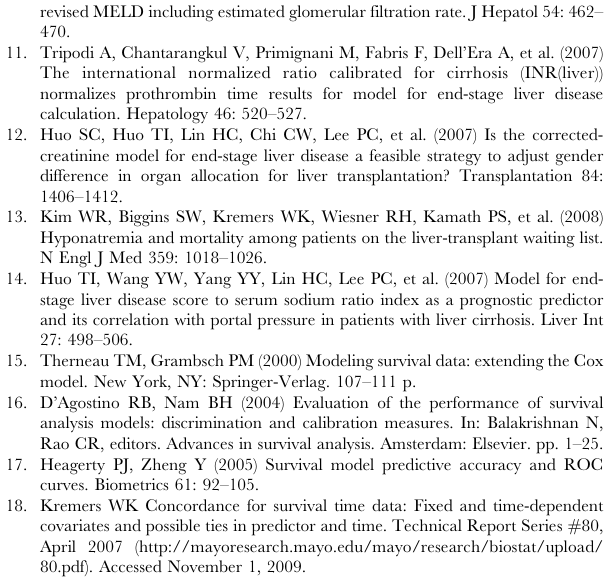
Figure S1 Serum albumin concentration and the risk of death within 3 months of waiting list registration after adjustment for the MELDNa score. Dotted lines repre- sent 95% confidence intervals. Table S1 C-statistics (95% CI) of MELD and alternative models for predicting 3-month mortality on the liver transplant waiting list according to liver disease etiol- ogy. Table S2 Risk reclassification table comparing 90-day mortality risk strata according to MELDNa and 5vMELD. Table S3 MELD and MELDNa scores among 1,113 patients from the validation cohort who died on the waiting